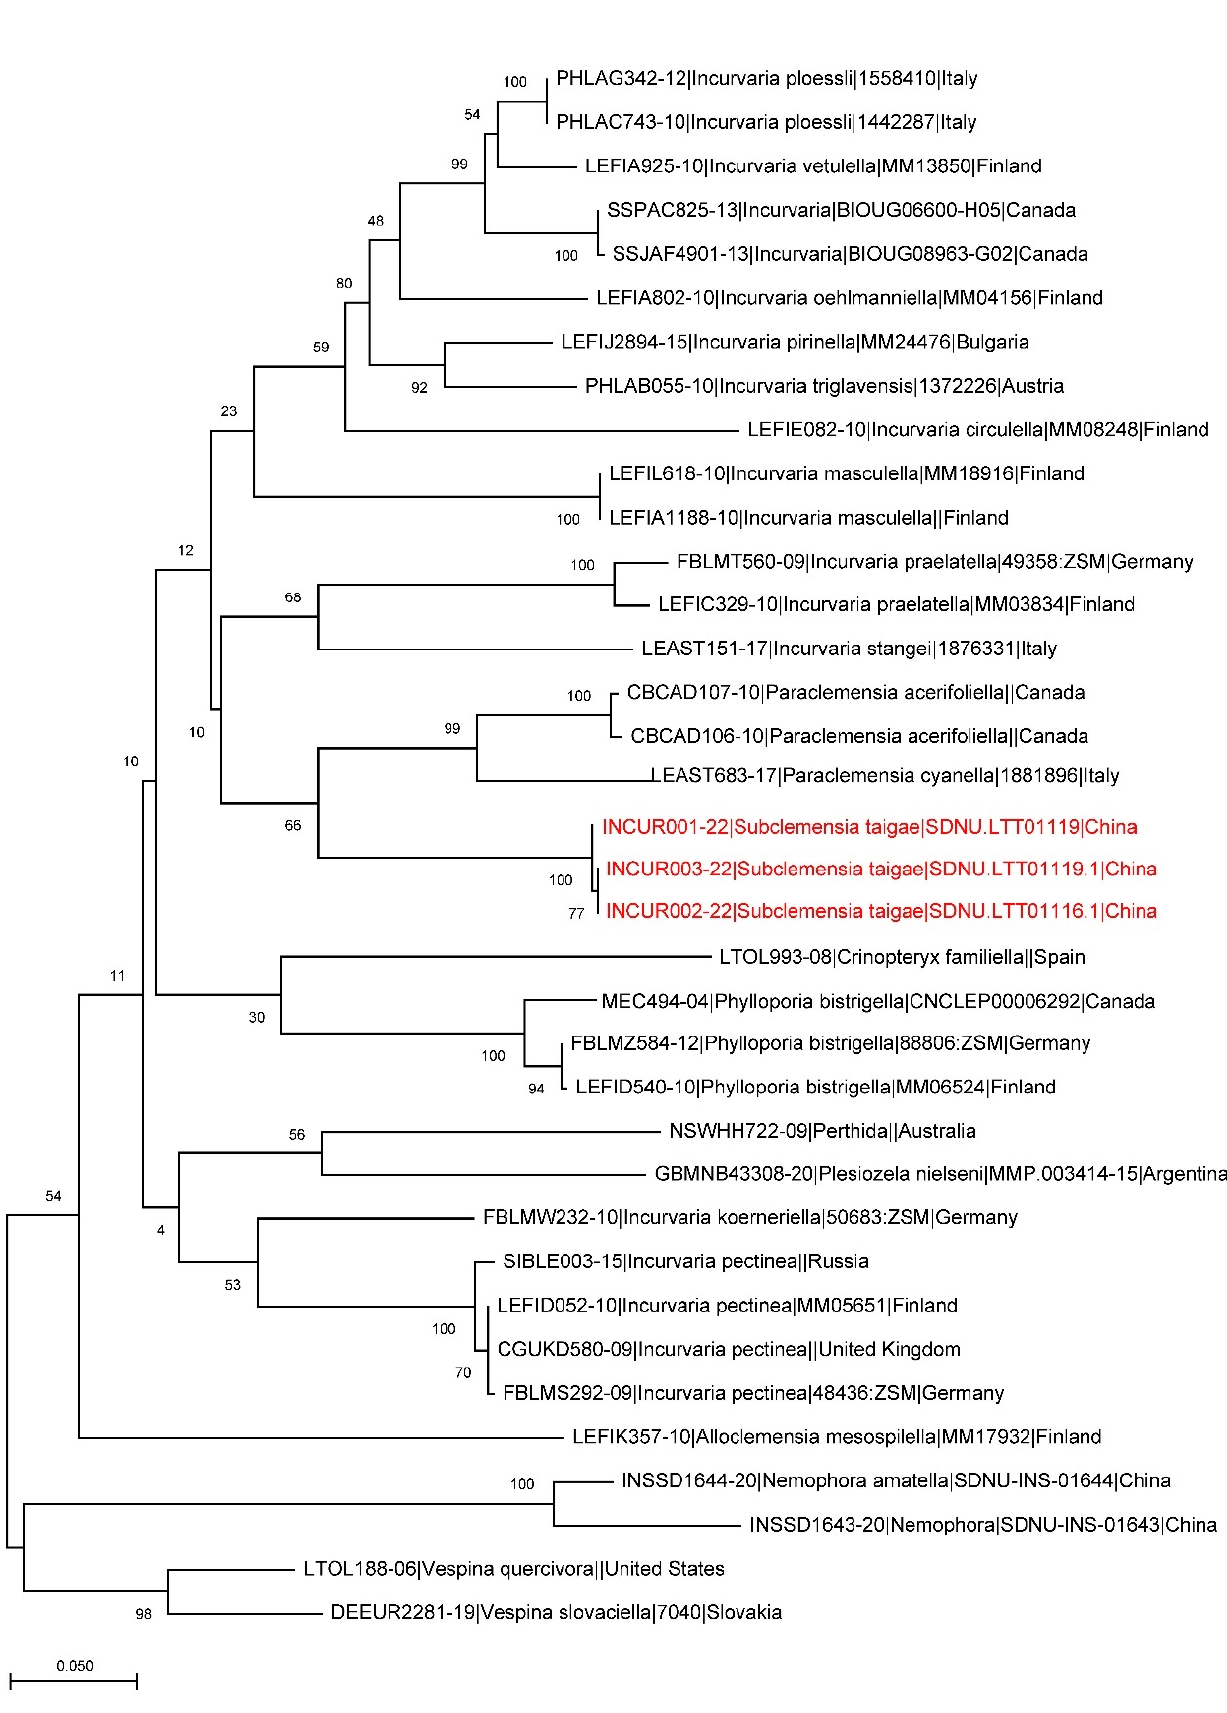
Figure 5. A maximum likelihood estimation based on available barcode sequences of Incurvariidae. The branches of Subclemensia taigae are marked red.